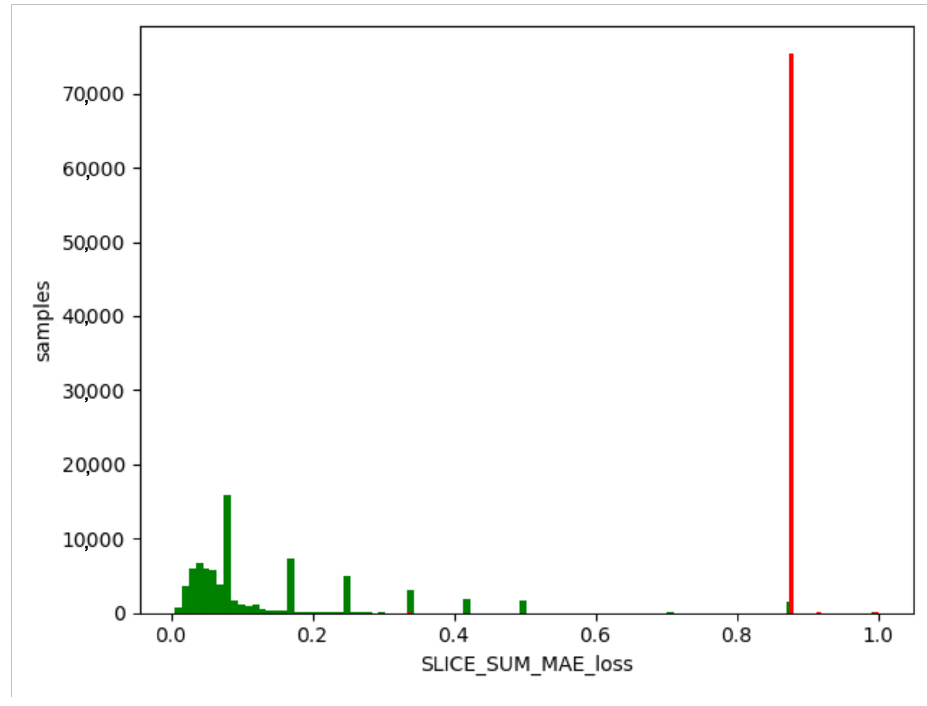
Figure 16. UNSW-NB15 evaluating set. Green indicates normal data and red indicates abnormal